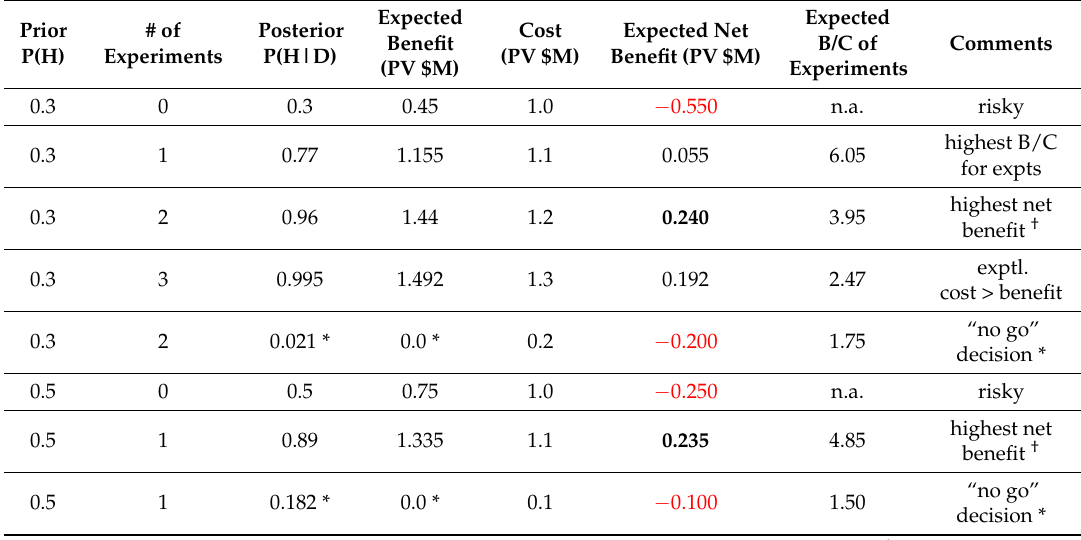
Table 3. Posterior analysis of probability of success as a result of up to three independent experiments (with characteristics of Table 2) influence the decision to proceed with building the treatment plant and the Bayesian expected benefit and net benefit, for prior probabilities of viability of 0.3 and 0.5. The benefit cost ratios of performing the experiments are also